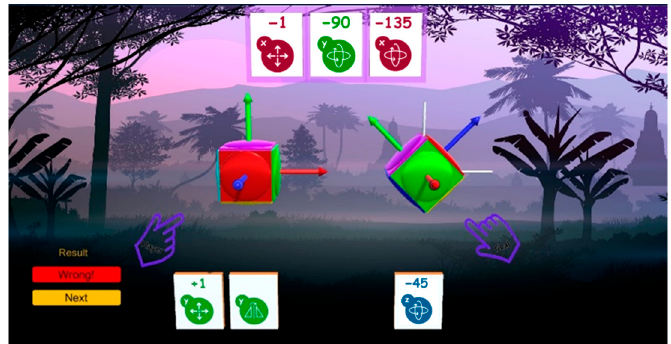
Figure 13. GTCards: game’s main interface.